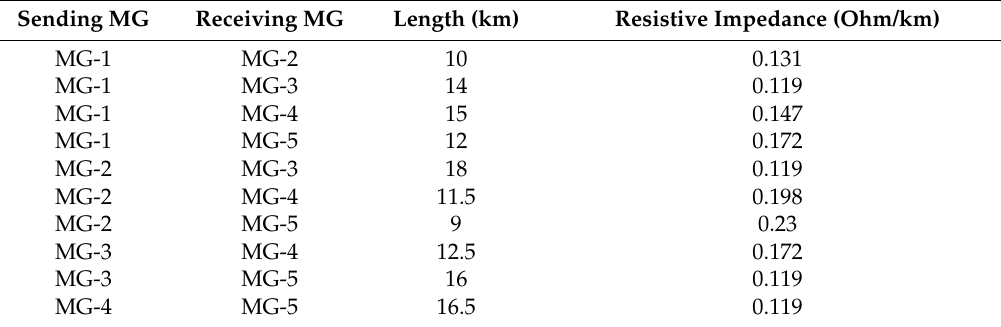
Table 2. Assumed data of transmission lines between Micro-Grids (MGs).